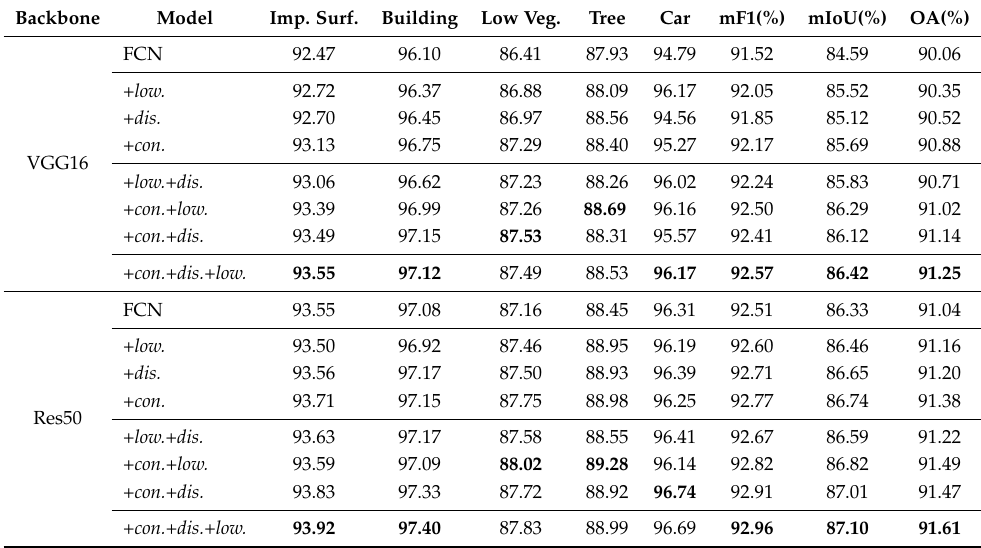
Table 8. The results of ablation study of multi-feature learning on Potsdam dataset.